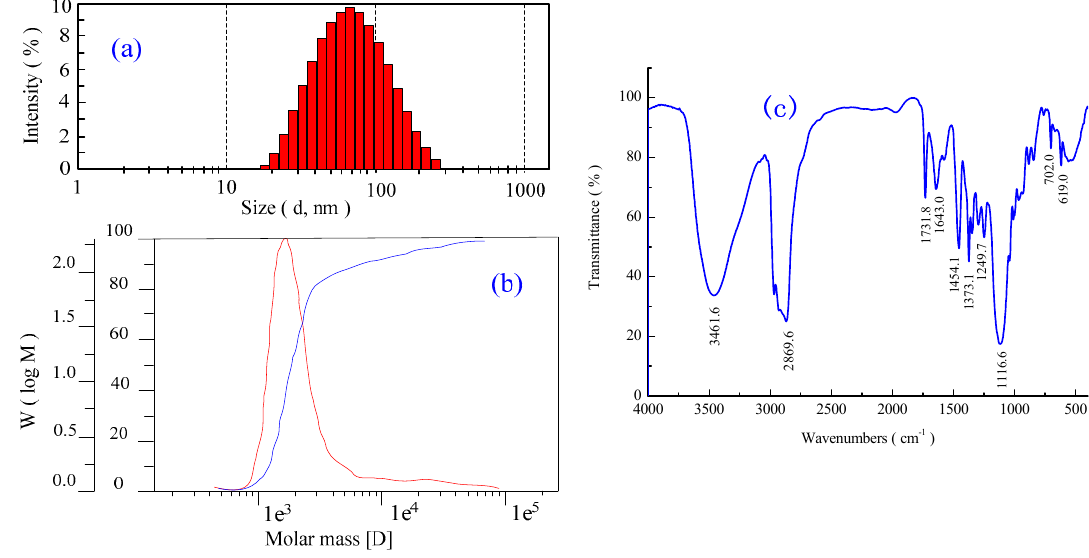
Figure 3. Structure characteristic of P[St-BA-F6] latex particle. ( a ) Size distribution of the P[St-BA-F6] latex particles. ( b ) Gel permeation chromatography (GPC) of P[St-BA-F6] latex. ( c ) Fourier transform infrared spectroscopy (FTIR) spectrum of P[St-BA-F6] composite.